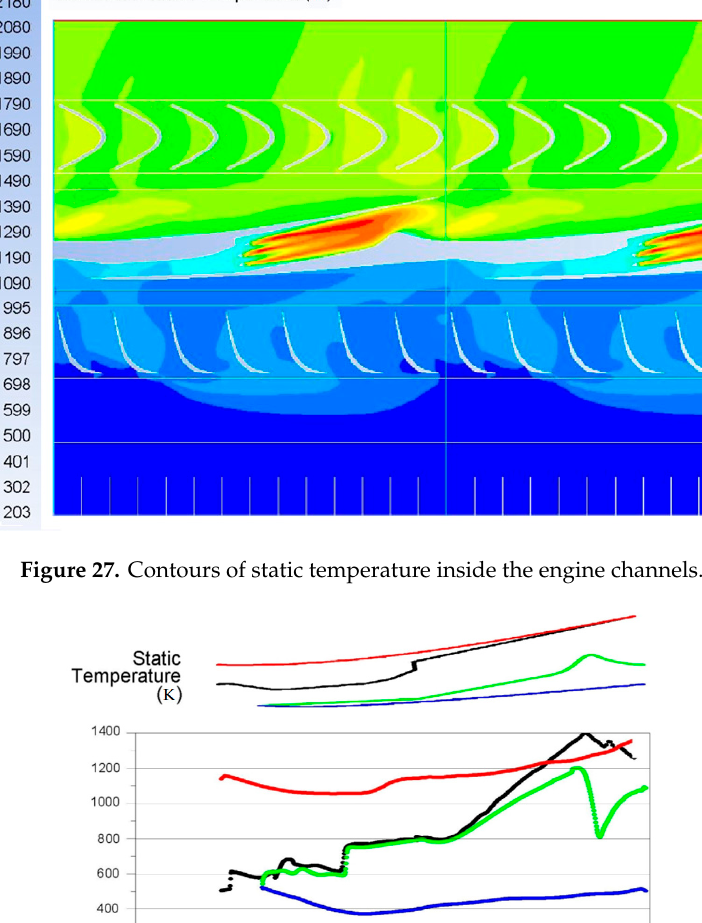
Table 1. Estimated engine parameters.